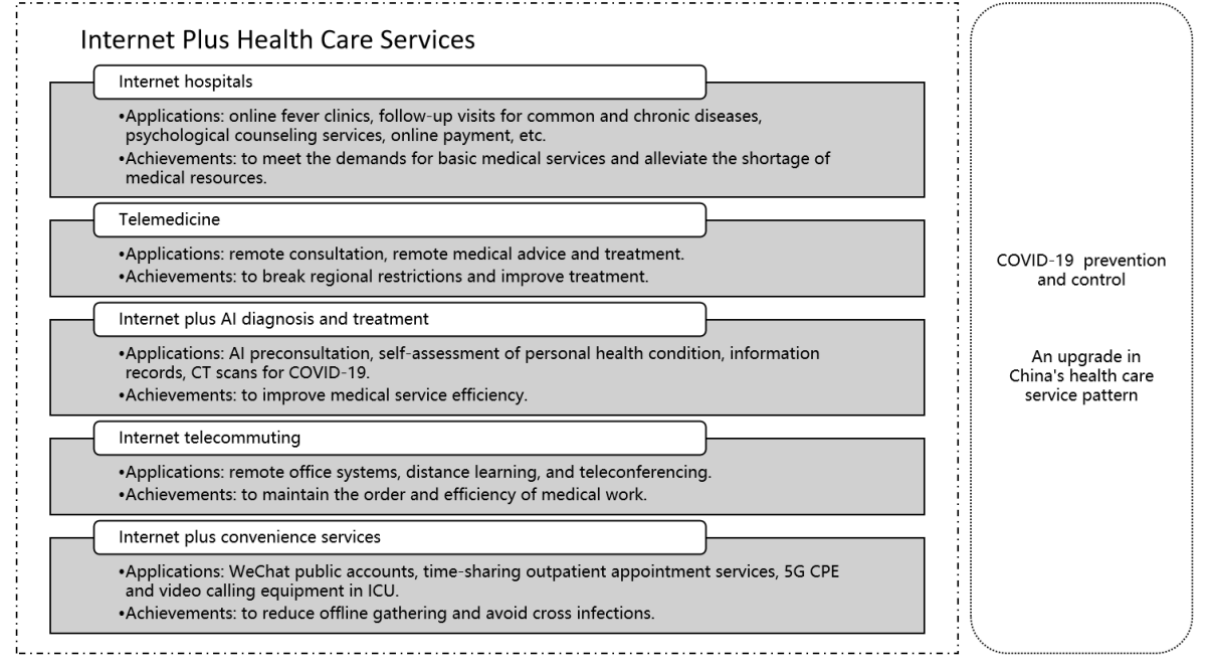
Figure 3. The applications and achievements of internet plus health care in COVID-19. AI: artificial intelligence, CT: computed tomography, CPE: customer premise equipment, ICU: intensive care